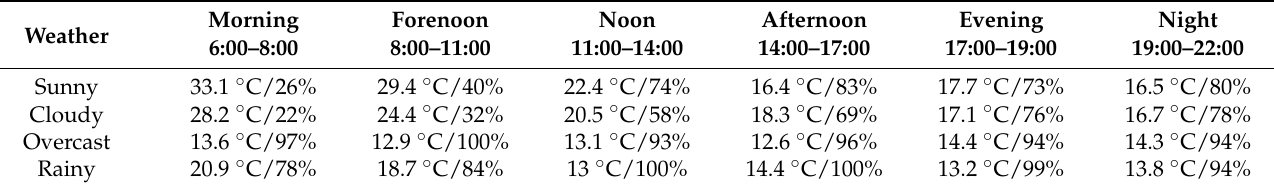
Table 1. Outdoor meteorological parameters (air temperature/relative